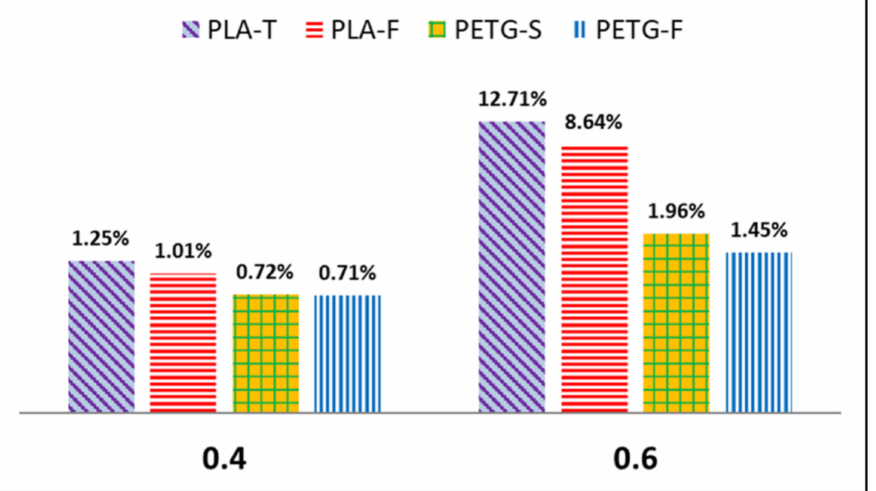
Figure 12. Porosity results of all the samples